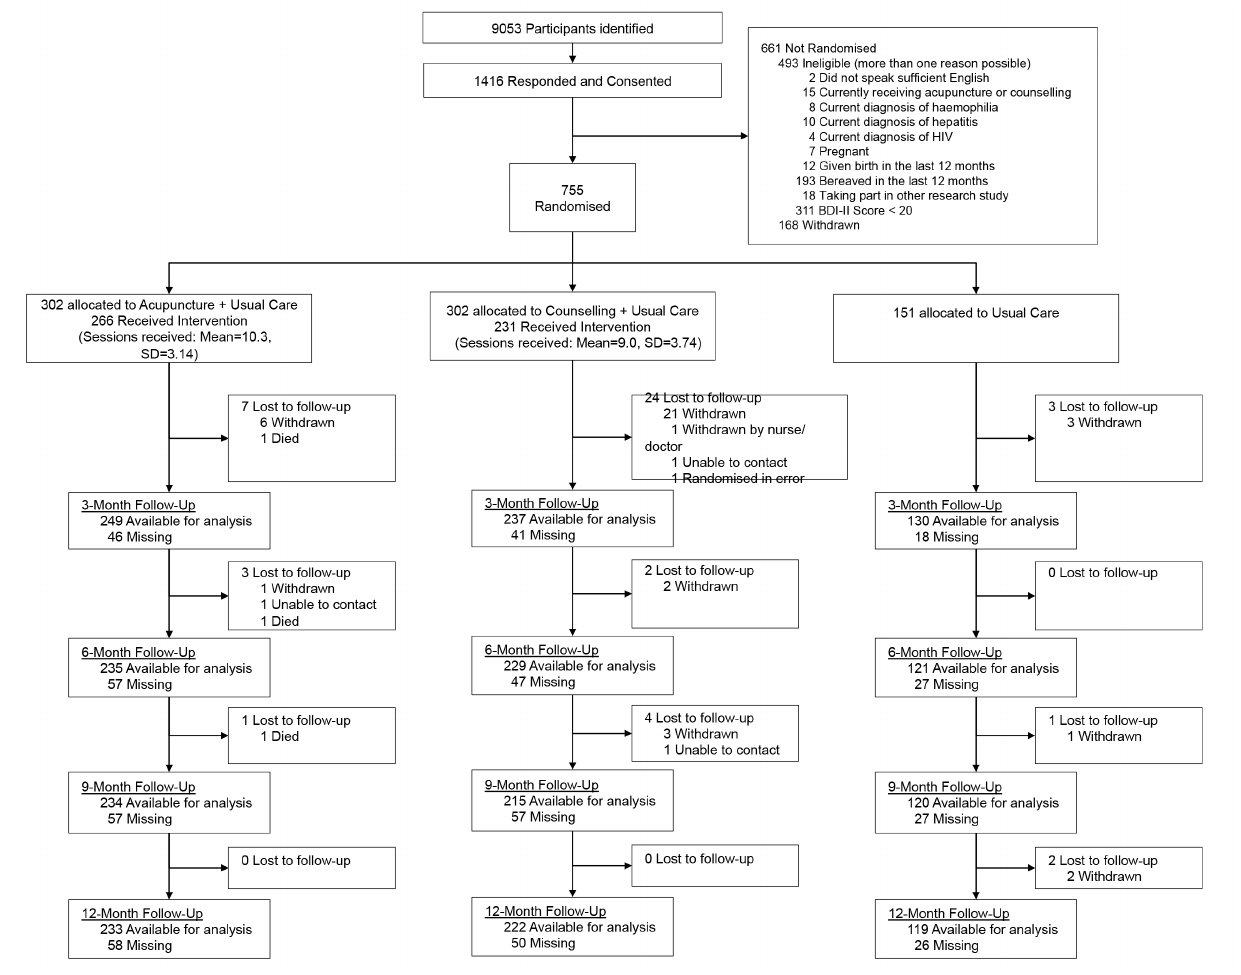
Figure 1. CONSORT flow diagram.